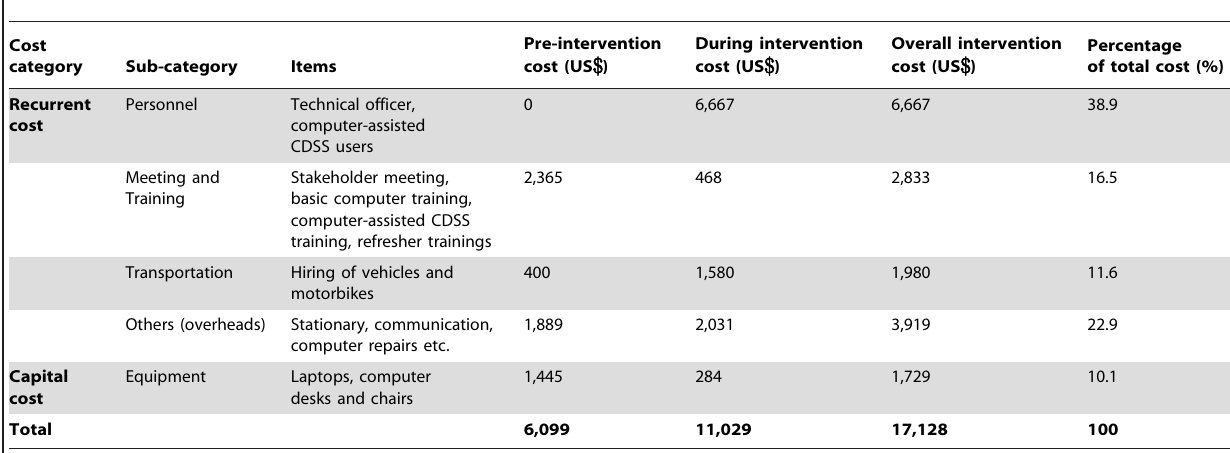
Table 4. Economic cost of computer-assisted CDSS Implementation (US $